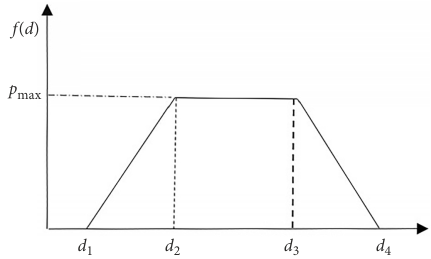
Figure 5. Probability density curve of